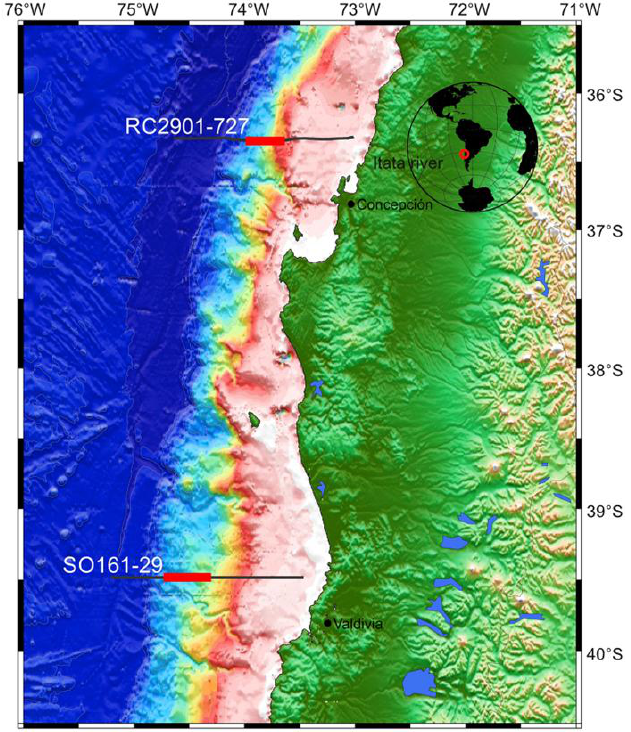
Figure 1. Location map of the two analysed seismic sections (black lines). The red segments indicate the analysed parts.